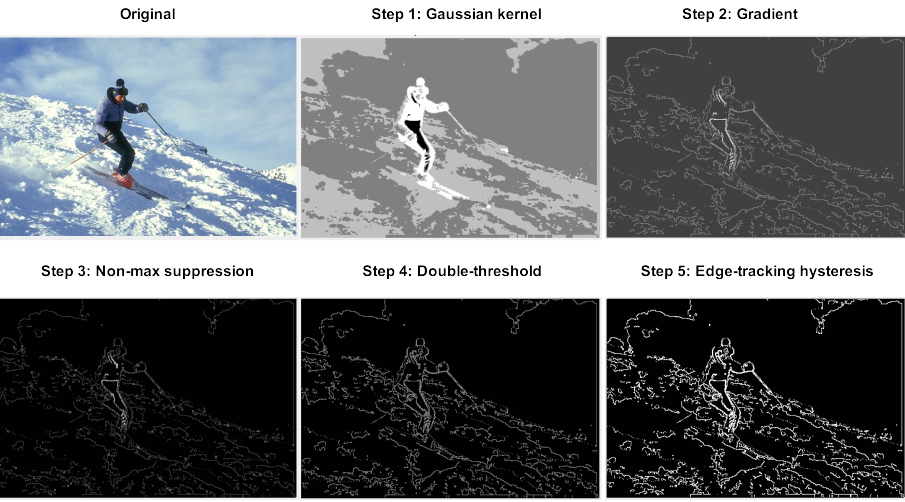
Figure 2. The original and the output images from all 5 stages of neuromorphic Canny edge